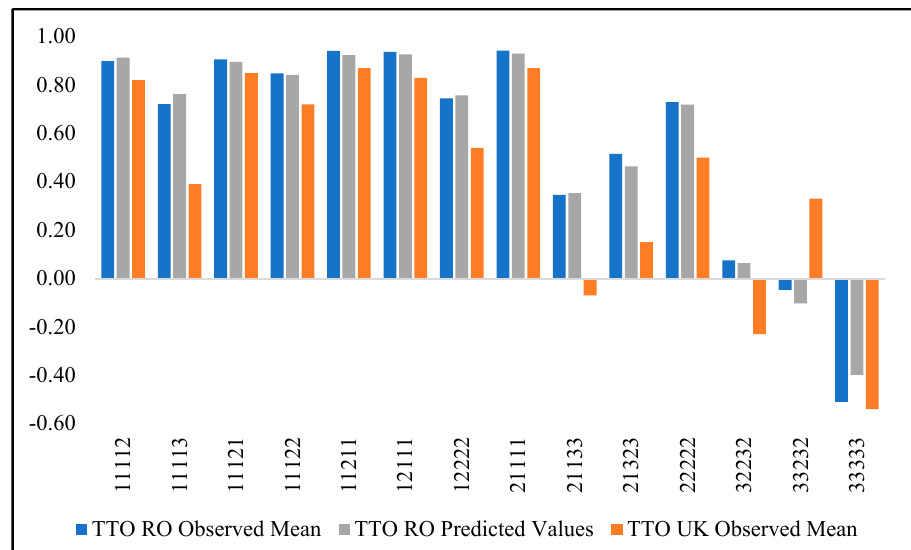
Figure 2. Mean observed TTO values for Romania and the UK.